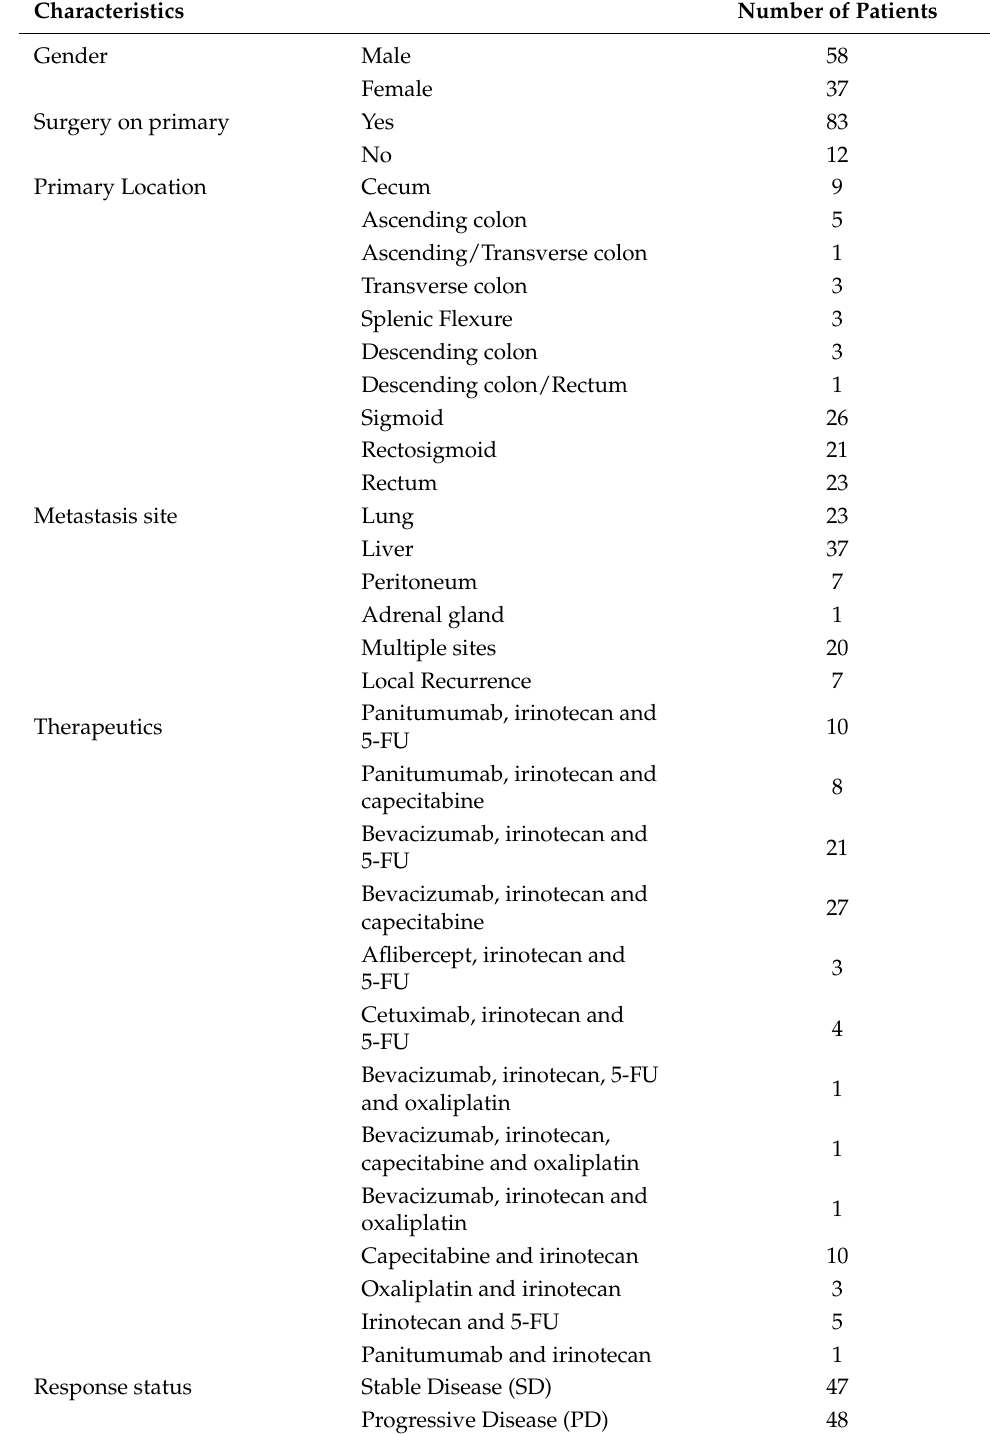
Table 2. Clinicopathological characteristics of the study